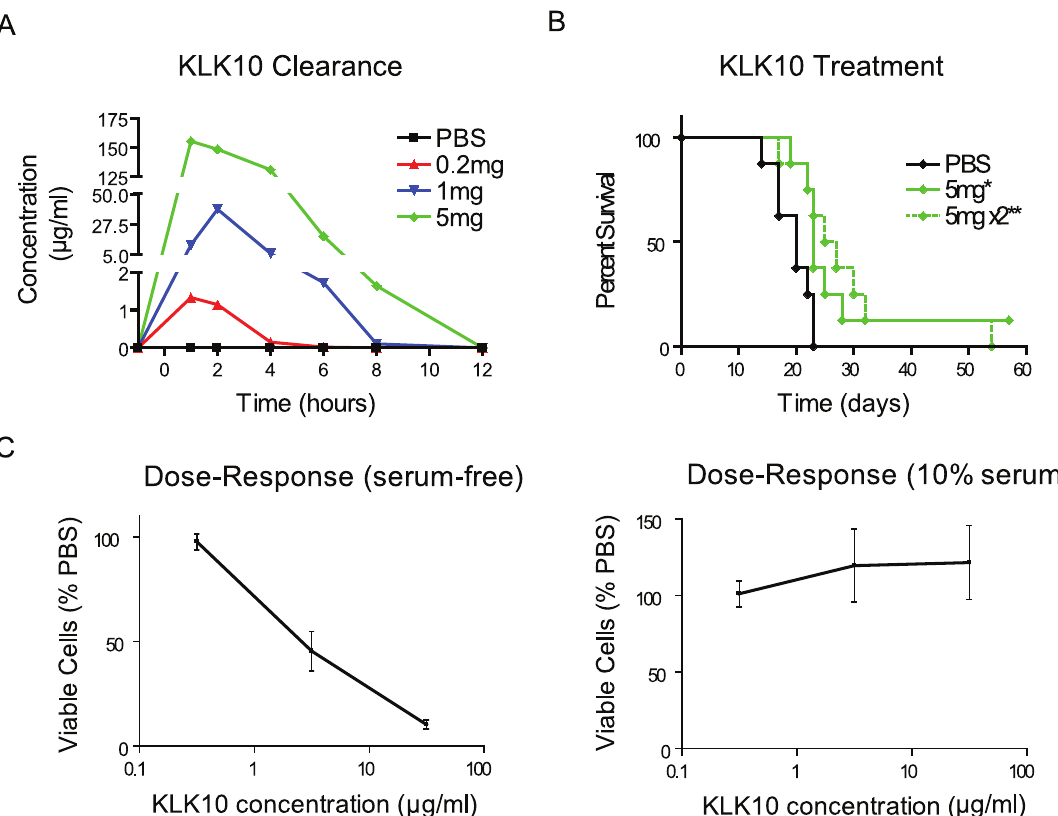
Figure 4. Treatment of mice xenografted with ES-2 cells with various IP doses of recombinant KLK10. A) Mice were injected with a bolus of recombinant KLK10 IP and blood samples were taken at different time intervals to measure plasma concentrations of KLK10 by ELISA. B) Mice were injected IP with either PBS or recombinant KLK10 daily or twice daily for 14 days post xenograft with ES-2 in a survival experiment. C) ES-2 cells were treated with various doses of recombinant KLK10 (0, 0.3, 3, 30 m g/ml) for 96 h in serum-free or serum-containing media and cell viability was determined by trypan blue exclusion. * denotes p , 0.05, ** denotes p , 0.01, and *** p , 0.001.